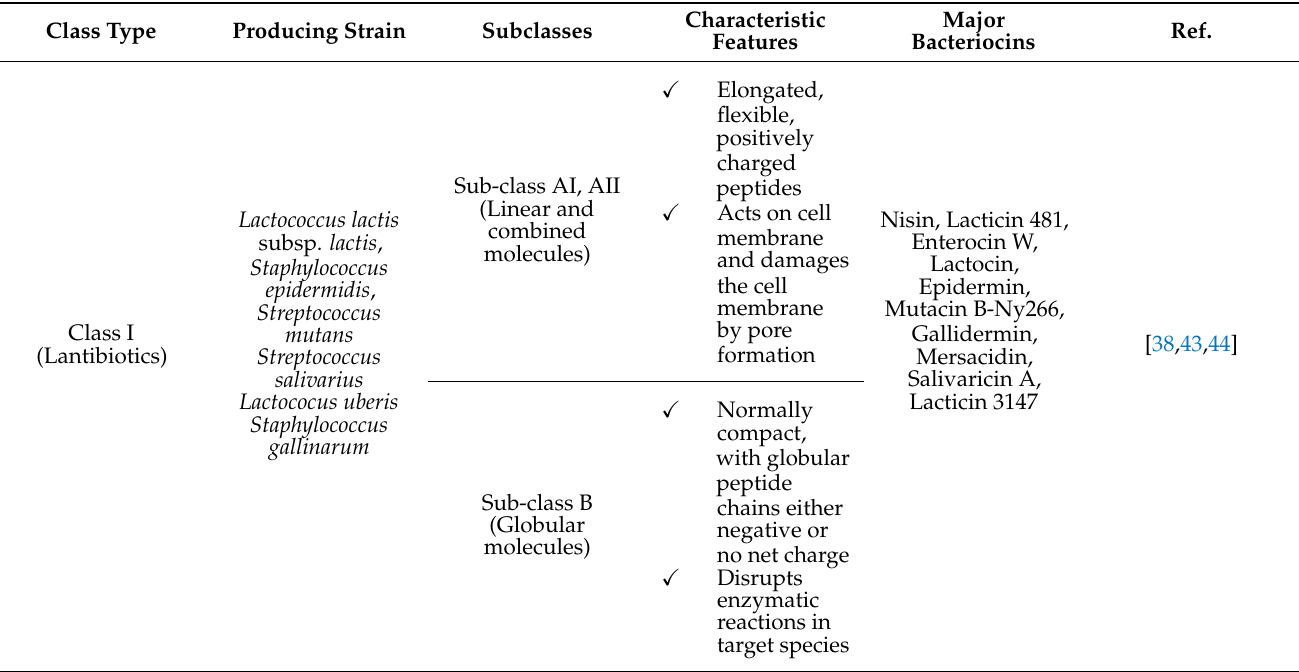
Table 1. Different classes of bacteriocins and their characteristic